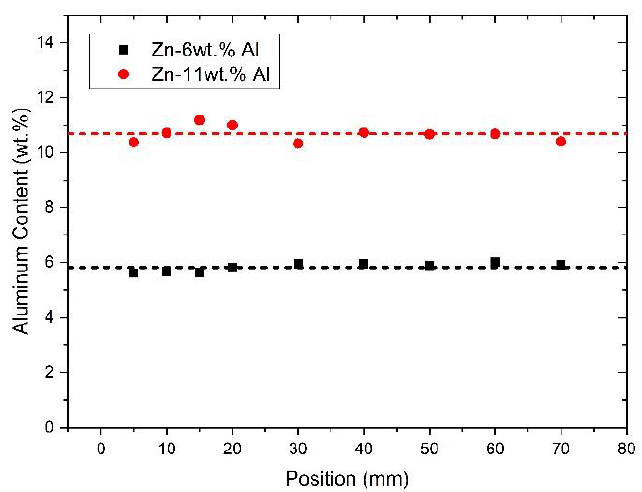
Figure 8. Al concentration profiles along the length of the DS Zn – Al castings.